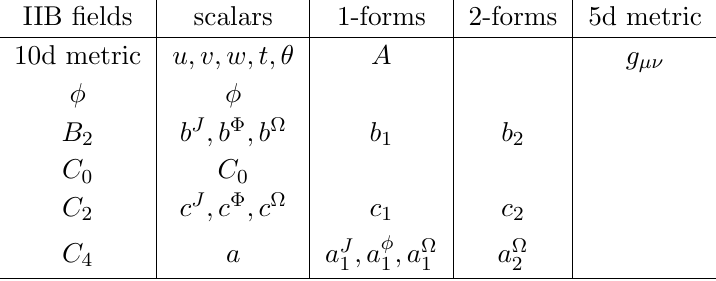
Table 1 . 5d (cid:12)elds along with their 10d